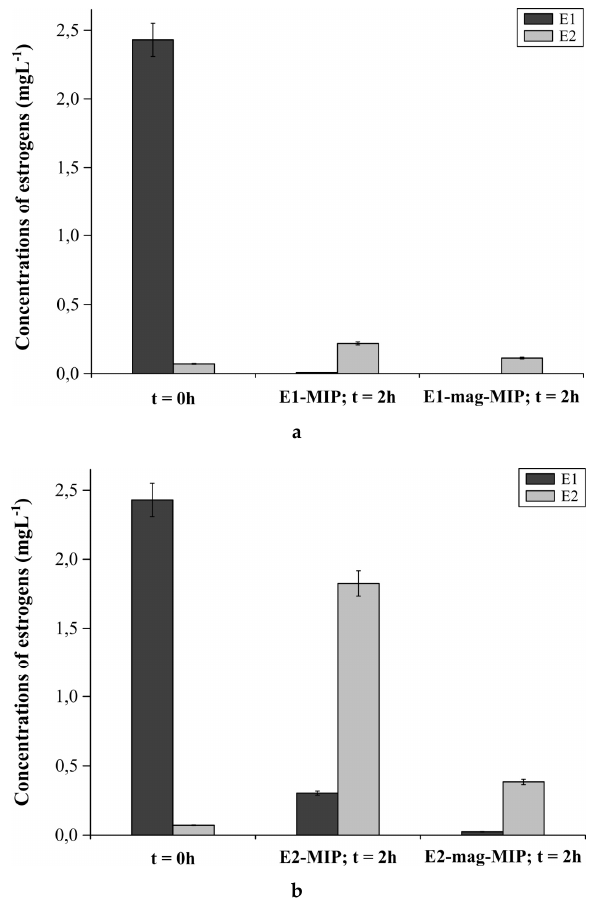
Figure 6. ( a ) Concentration of E1 and E2 in E1 aqueous solution before addition of the materials and 2 h after the addition of E1-MIP and E1-mag-MIP. ( b ) Concentration of E1 and E2 in E1 aqueous solution before addition of the materials and 2 h after the addition of E2-MIP and E2-mag-MIP. Based on the amount of E1 in the solution after 2 h, in the samples to which E1-MIP and E1-mag- MIP were added, the sorption capacity of the materials was determined. E1-MIP bound 0.02 g of E1 per 1 g of the polymer. In comparison, while 1 g of a E1-mag-MIP bound 0.03 g of E1. During the measurement at time t = 0 h for E1 solution, the low intensity signal assigned to E2 was observed. It is a result of the rapid conversion of E1 into the more stable E2 in the aqueous environment. Two hours after the addition of E1-mag-MIP, no signals from E1 in the solutions were detected, indicating the complete binding of the analyte to the selective cavities in the polymer structure. In the sample with E1-MIP, a low intensity signal, confirming the presence of small amounts of E1, was recorded. This confirms that the mag-MIPs adsorb analyte more efficiently. After 2 h, in both cases, the presence of E2 was found, indicating rapid conversion of E1 after the release from the polymer structure (as a result of the equilibrium state), occurring before the non-converted molecules were bound again. In the E1-mag-MIP solution, a signal of lower intensity was recorded. The detected signals from E2 indicate that it was not adsorbed within the E1-MIP and E1-mag-MIP structure, which confirms the selectivity of the obtained material.